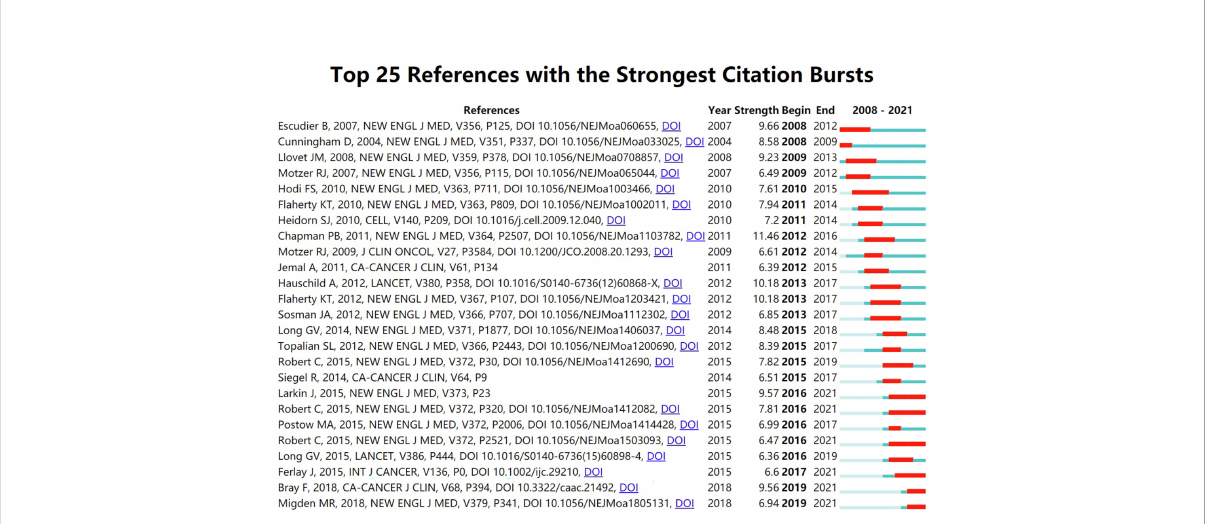
FIGURE 7 The top 25 references with the strongest citation. (The green line segment represents the time interval, and the red line segment represents the active